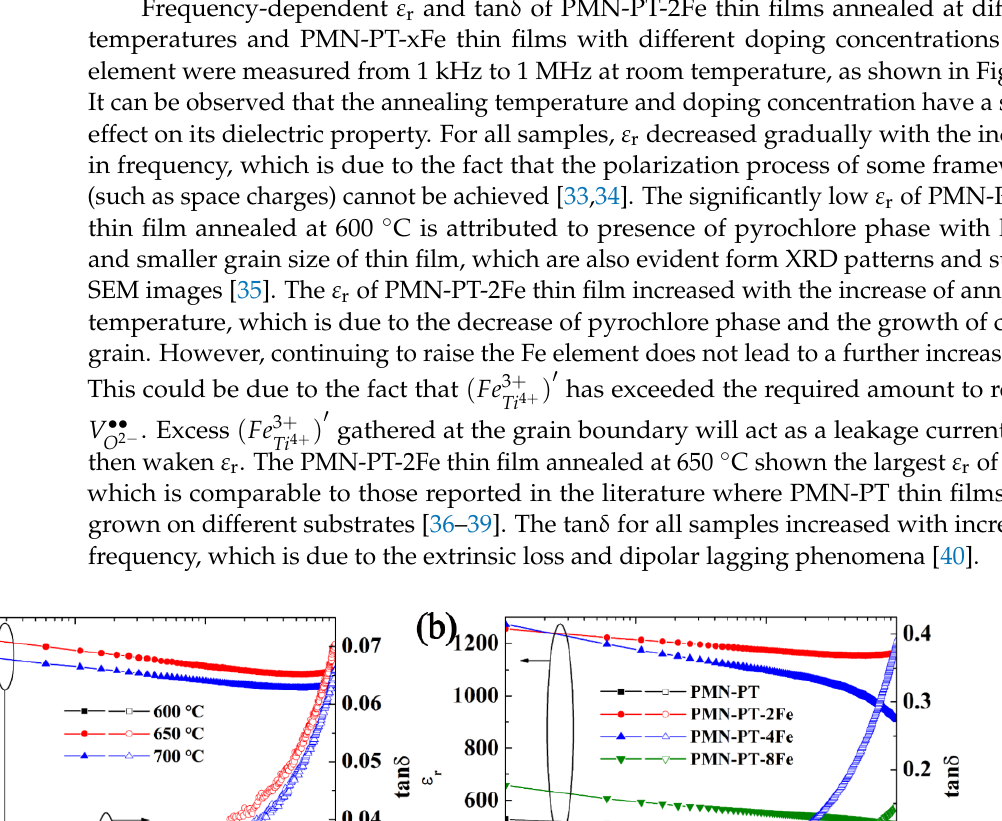
Figure 7. ( a ) Voltage dependence of ε r and tanδ for PMN-PT-2Fe thin films annealed at different temperatures, ( b ) Voltage dependence of ε r and tanδ for PMN -PT-xFe thin films with different doping concentrations of Fe element.